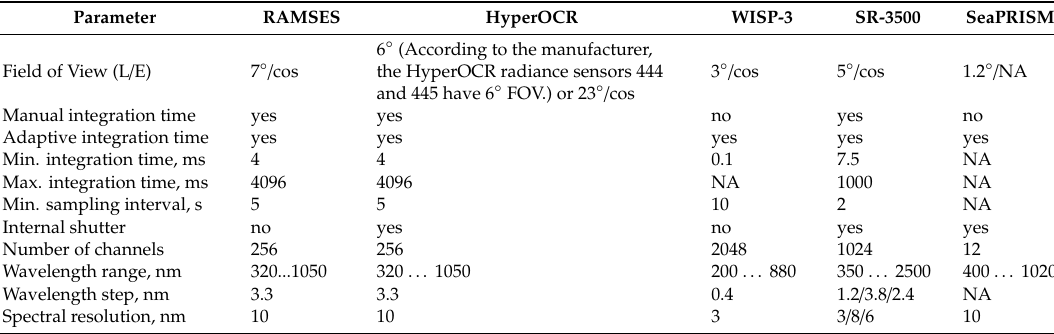
Figure 2. Instruments participating in the LCE-2 intercomparison. Table 2. Technical parameters of the participating radiometers